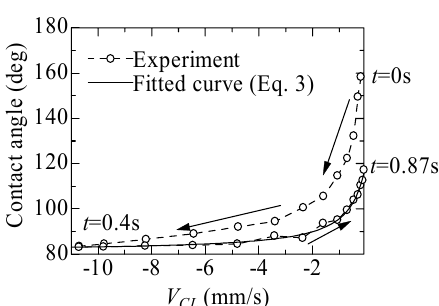
Fig. 6 Contact angle vs. relative velocity between wall and contact